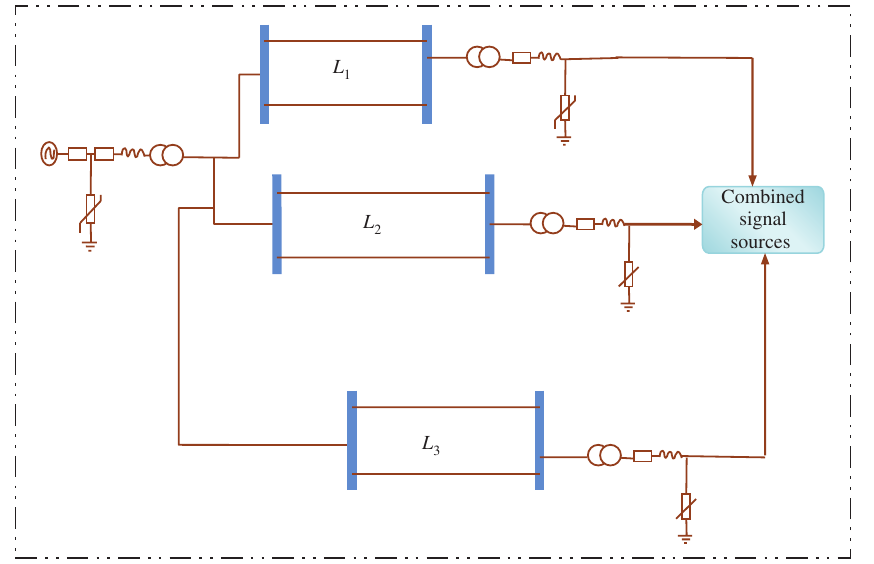
Figure 2: Power Distribution System with Loading at Diverse